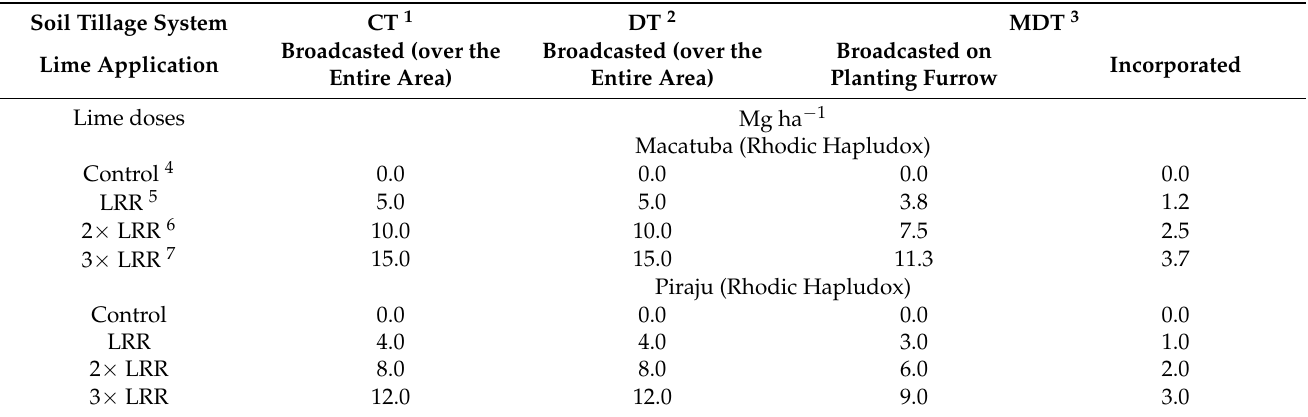
Table 2. Lime doses and forms of application under different soil tillage